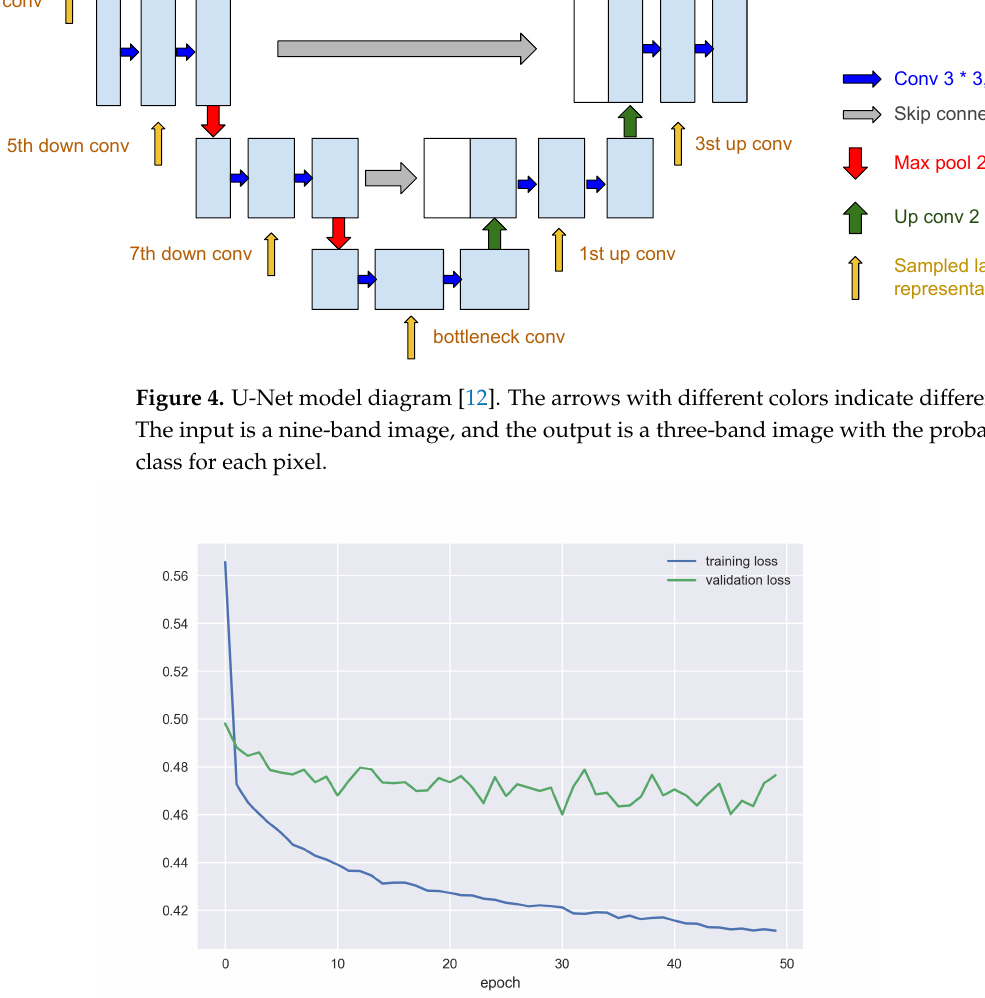
Figure 5. The training loss curve. The blue line corresponds to the training loss. It decreases over epochs indicating the model is learning features from data. The green line corresponds to the valida- tion loss. It first decreases and then becomes relatively steady, meaning the model has